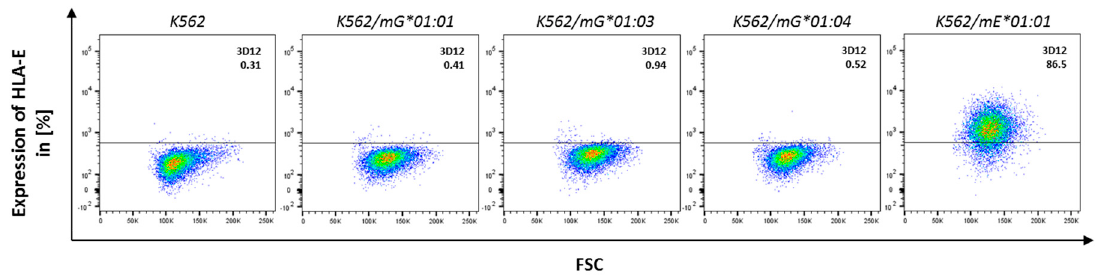
Figure A8. FACS analysis of HLA-E expression in HLA-G transduced K562 cells. Transduced cells were analyzed with an anti-HLA-E antibody (clone 3D12) for the presence of HLA-E on the cell surface. K562 cells served as negative control and transduced K562 / mE*01:01 cells served as positive